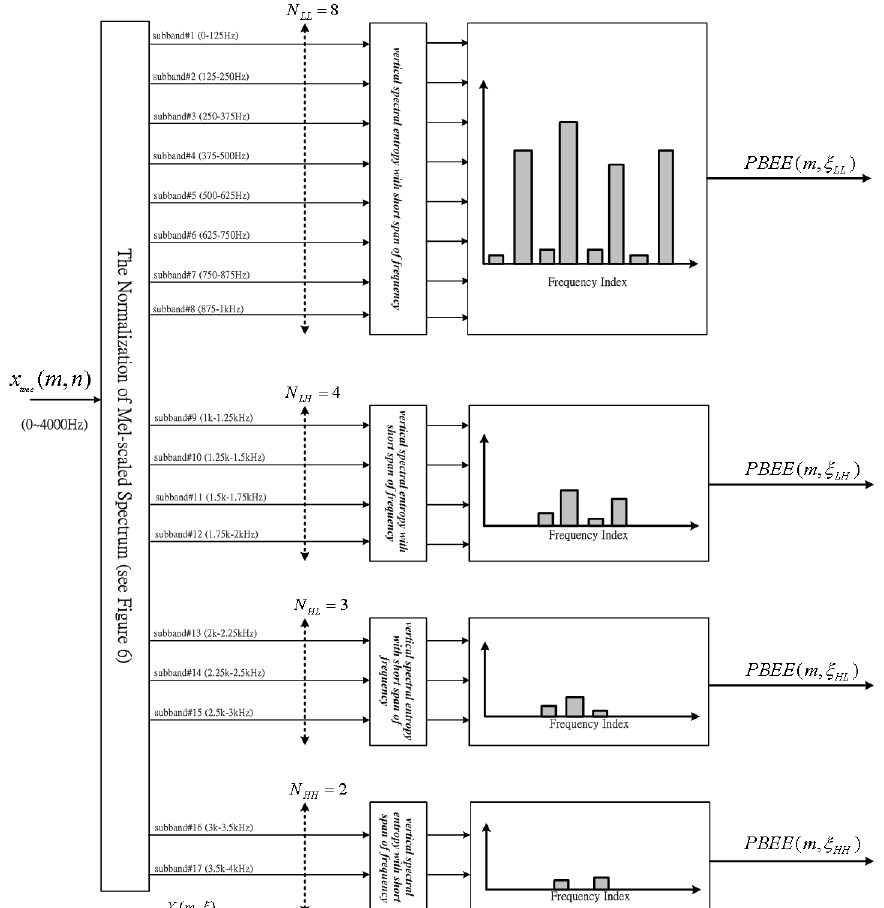
Figure 3. The block diagram of four PBEE values determined from four